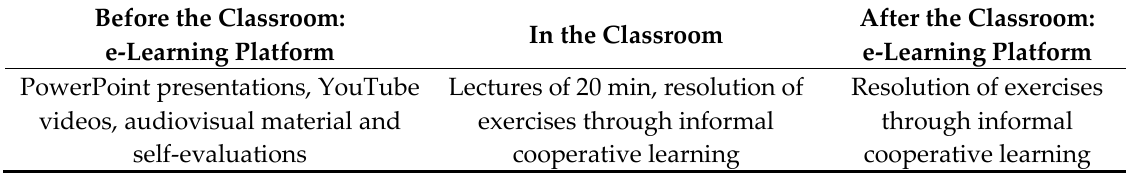
Table 1. Methodologies in class.